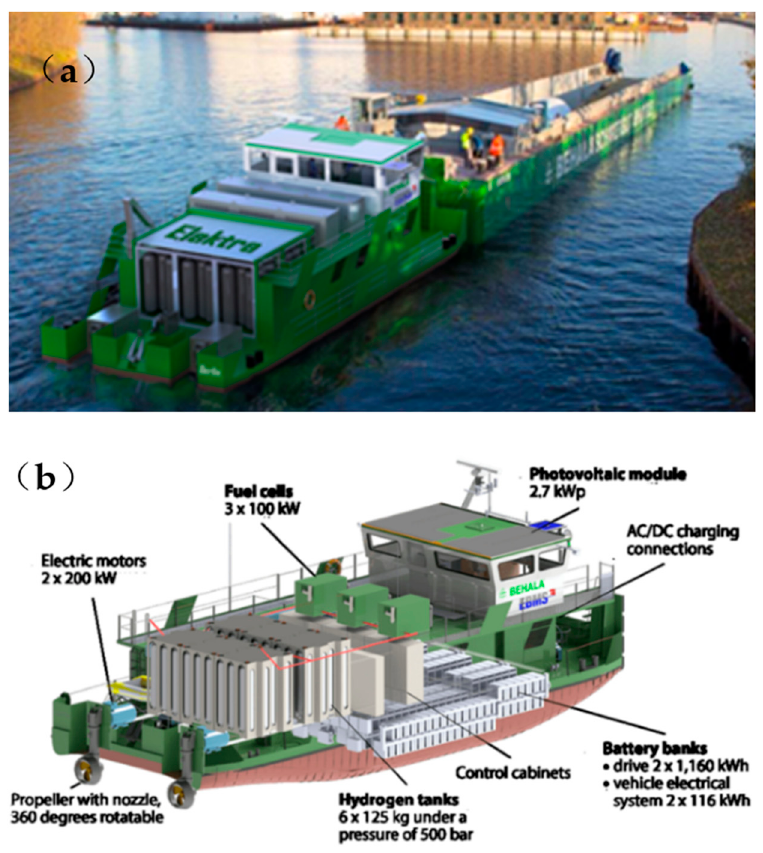
Figure 7. ( a ) The real ship “Elektra” [56]; ( b ) the conceptual design of “Elektra” [59].